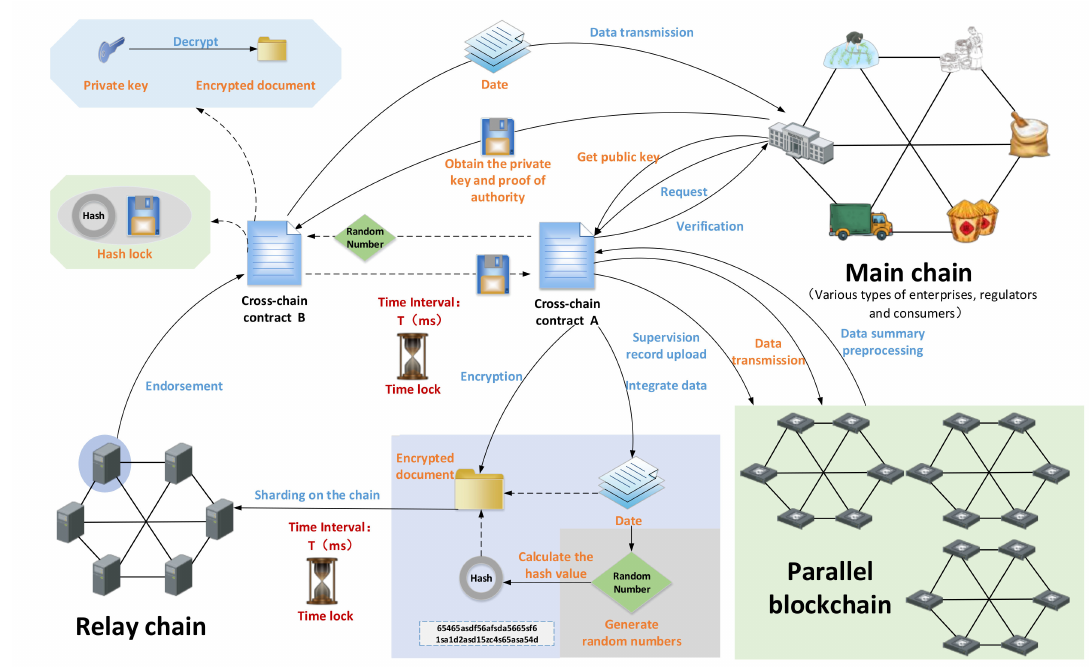
Figure 4. Schematic diagram of supervision cross-chain mechanism.